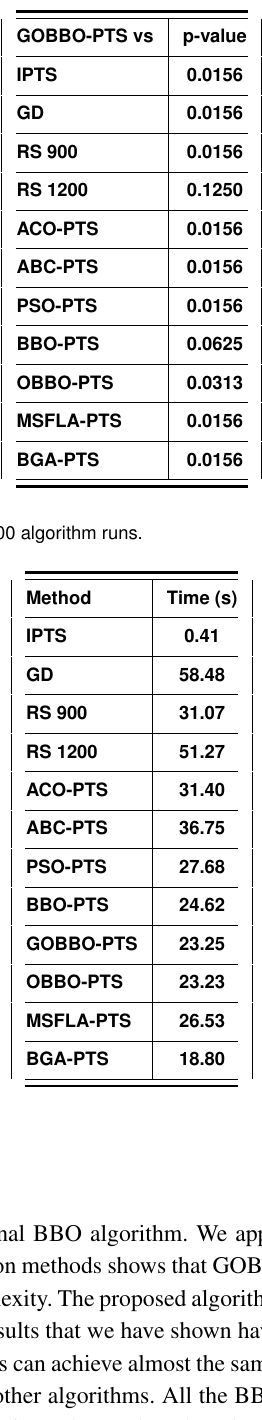
Table 7. Wilcoxon signed-rank test between GOBBO-PTS and the other methods.